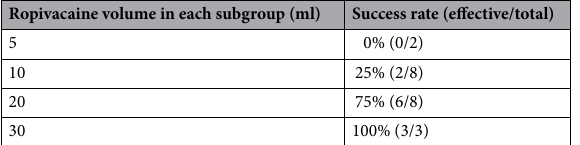
Table 2. Percentages of patients who had effective supra-inguinal FICB in each subgroups. FICB fascia iliaca compartment block.